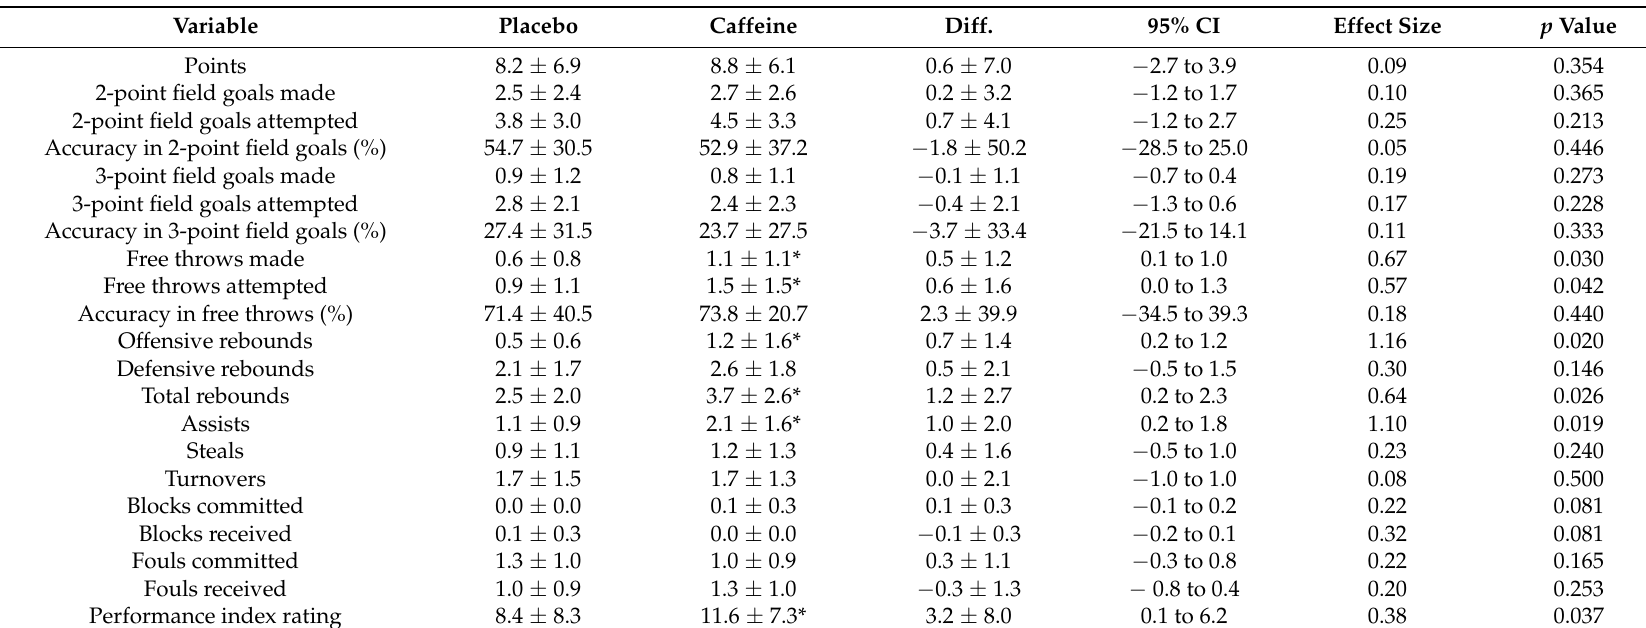
Table 1. Game-related statistics with the ingestion of caffeine (3 mg of caffeine per kg of body mass) or a placebo. Data are mean ± standard deviation for 20 basketball